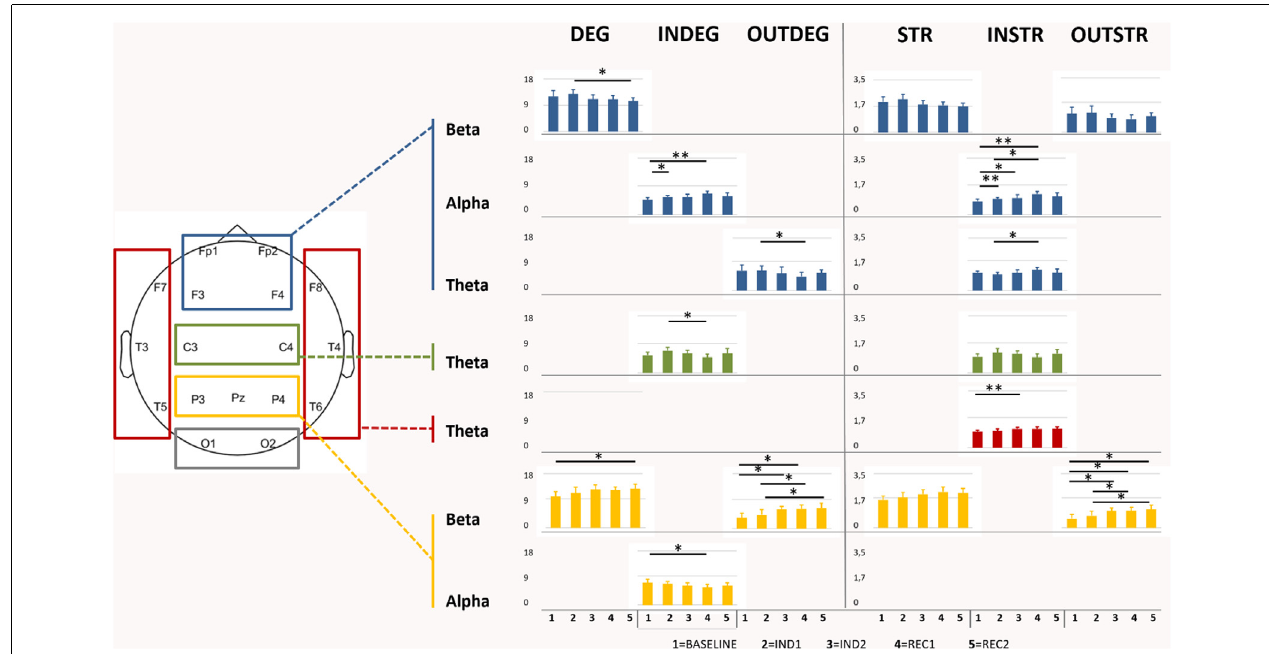
FIGURE 4 | Graphical representation of the significant differences of degree (DEG), Strength (STR), and the directional in/out-degree (INDEG/OUTDEG) and strength (INSTR/OUTSTR) values in each ROIs for each anesthesia period and EEG bands. Note: frontal area showed an increase in the in indexes in the alpha bands during the induction revealing different statistical differences between some periods whereas the statistically significant comparisons in the out indexes were highlighted in the beta band in the parietal area. ∗ p < 0.05; ∗∗ p <